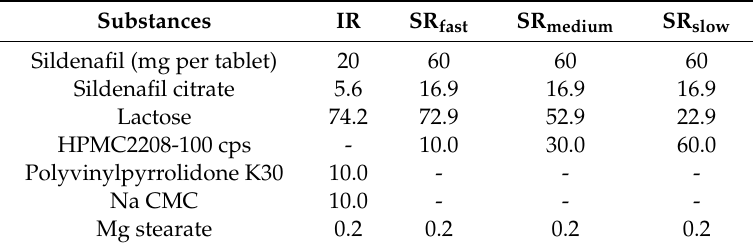
Table 1. Compositions ( w / w %) of sildenafil